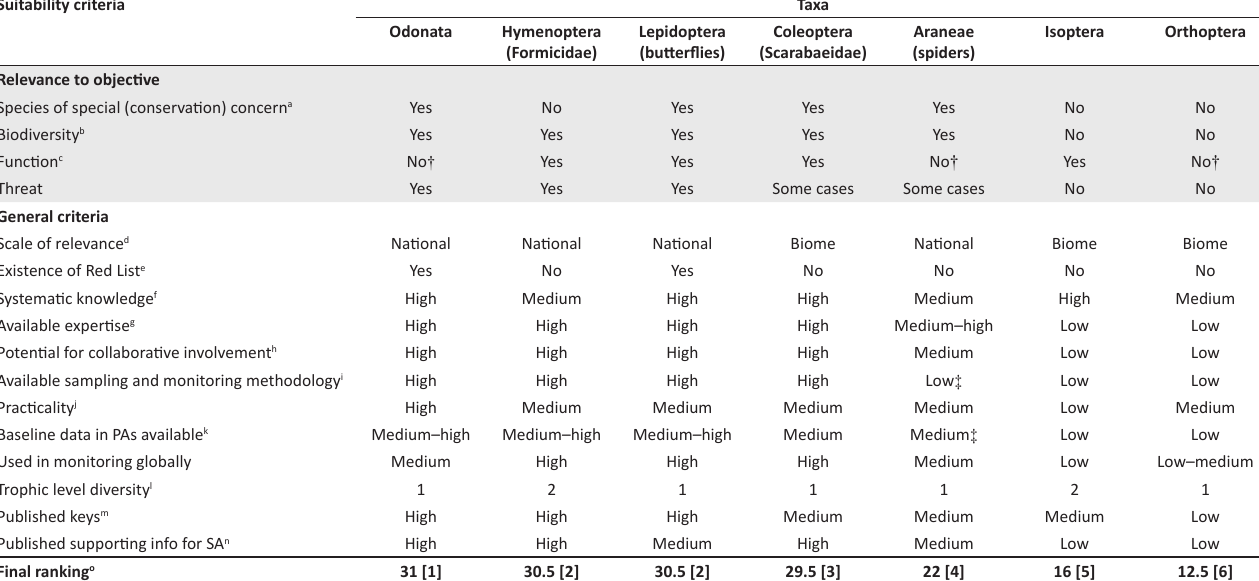
TABLE 3: An assessment of the suitability of taxonomic groups to be used for monitoring in protected areas, according to a range of objectives (see Table 1) and general suitability criteria. Suitability criteria